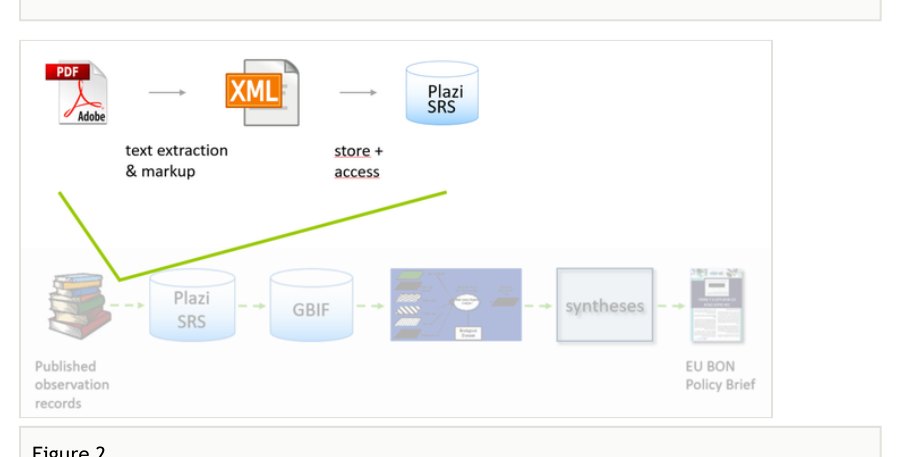
ARPHA consists of two integrated work fl ows: in ARPHA-XML, the manuscript is written and processed via the ARPHA Writing Tool, and in ARPHA-DOC, the manuscript is submitted and processed as document fi le(s).